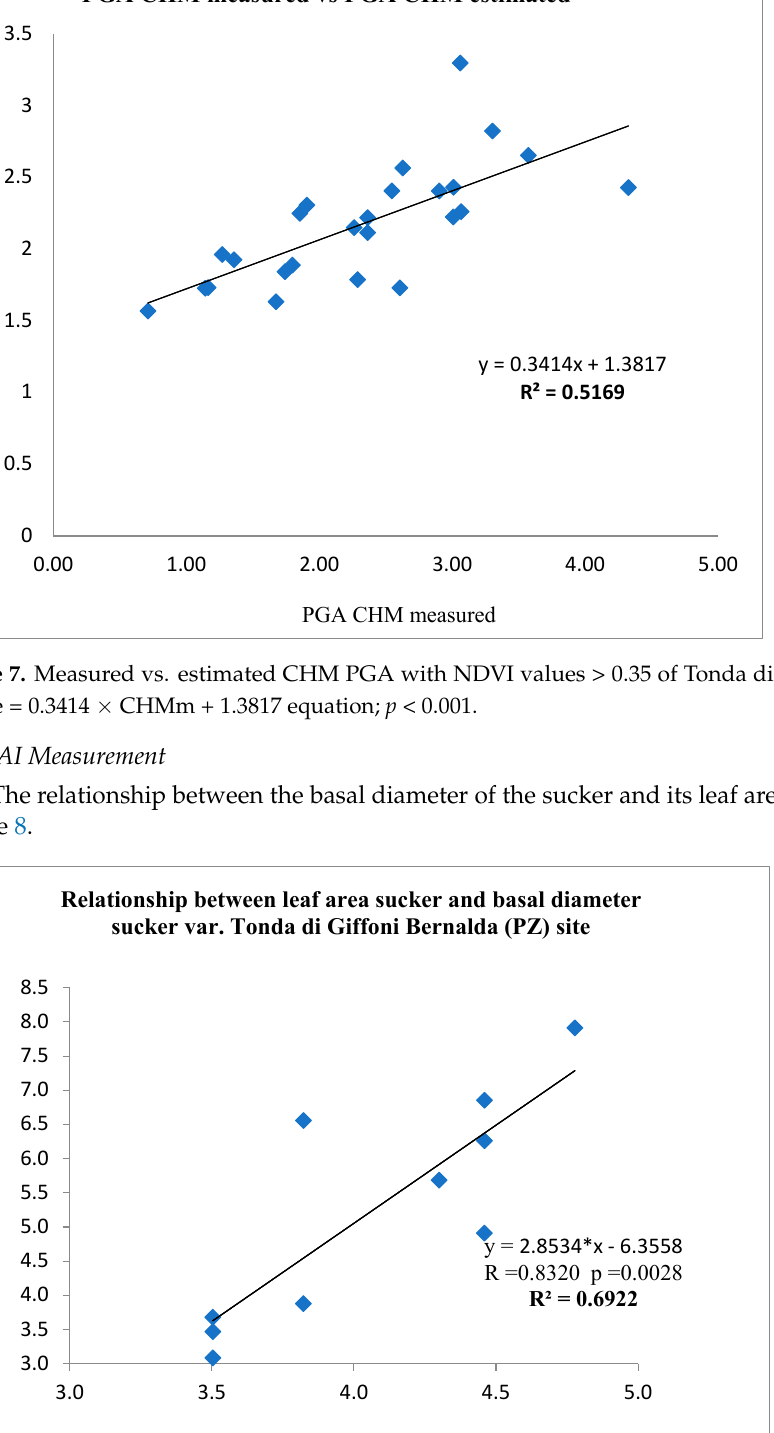
significance ( p < 0.001) and low regression was (R 2 = 0.5169) (Figure 7).